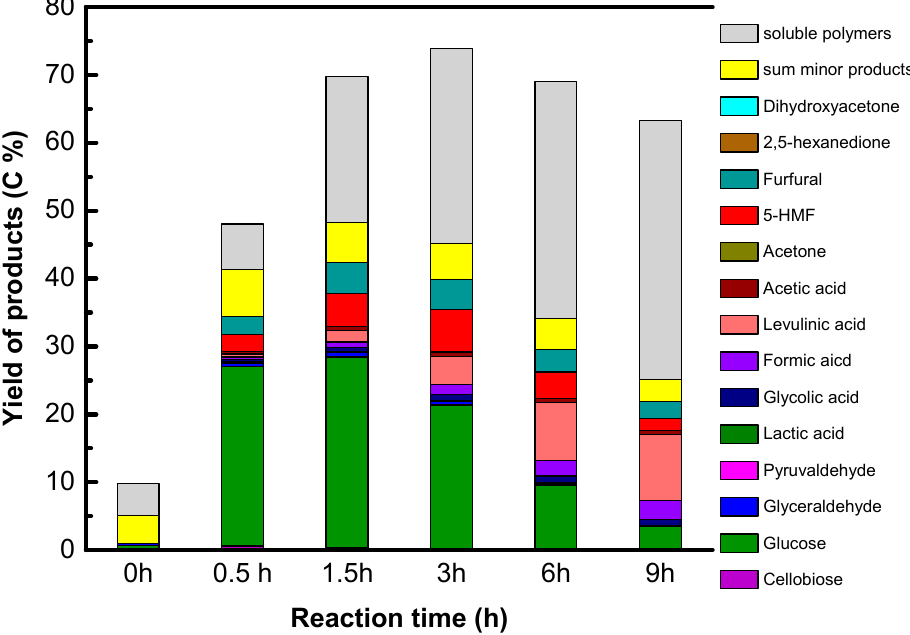
Figure 5. Kinetics of cellulose hydrolysis in liquid products catalyzed by GO. Reaction conditions: T = 190 °C, p~11at, m catalyst = 0.68 g, m cellulose = 1.6 g, m water = 65 g, and Ar Atm.